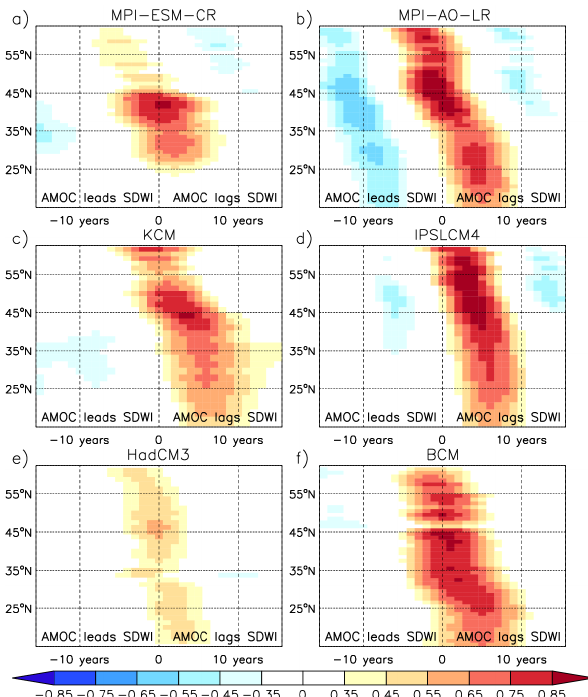
Fig. 3. Lag correlation coefficients between the bandpass-filtered (15–80 years) subpolar deep water formation index (SDWI) and maximum Atlantic meridional overturning streamfunction at differ- ent latitudes in the North Atlantic in the control simulation with (a) MPI-ESM-CR (depth level 1020m), (b) MPI-AO-LR (depth level 1020m), (c) KCM (depth level 870m), (d) IPSLCM4 (depth level 1210m), (e) HadCM3 (depth level 800m) and (f) BCM (depth level 1000m). Only correlation coefficients significant at the 95% level for a two-tailed t test (taking into account both length and decorrelation timescale of the SDWI and the overall maximum strength of the Atlantic meridional overturning streamfunction) are plotted (significance level: 0.31 for MPI-AO-LR, 0.27 for BCM and 0.23 for the other models). Positive (negative) lags indicate that the SDWI is leading (lagging).